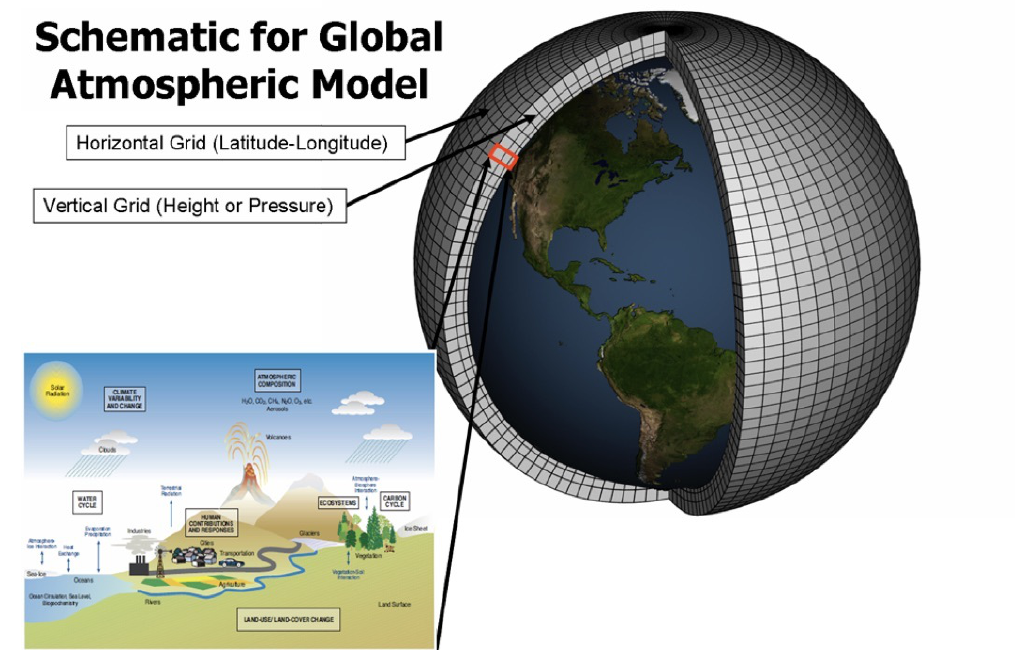
Figure 1: Graphic by